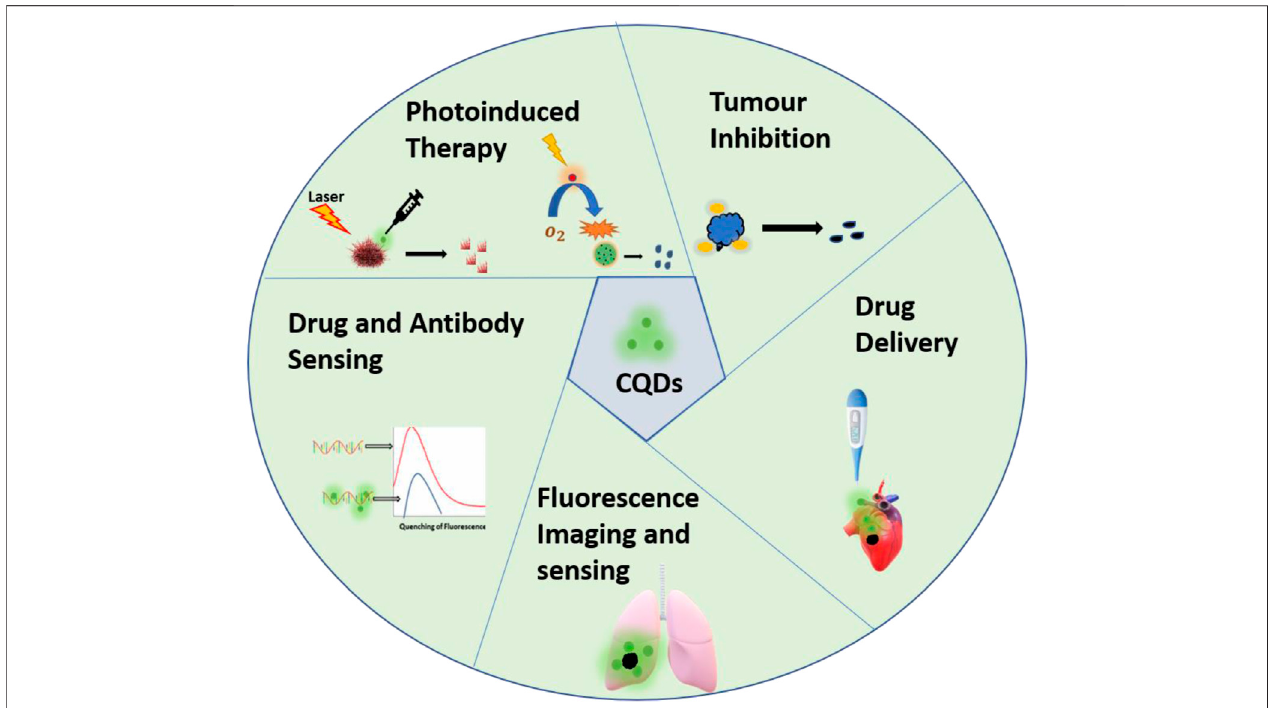
FIGURE 1 | Schematic representation of applications of CQDs derived from biomolecules and medicinal plants in cancer diagnosis and treatment.